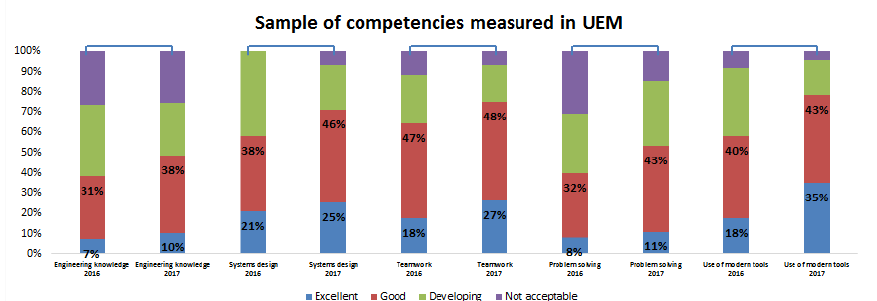
Fig. 3. Comparison of levels of achievement in UEM-related competencies in UTEC’s previ- ous vs. present education models. Faculty members were asked to fill-out detailed ru- brics for each student in every course and in relation to specific competencies. The bar graphs show a significant increase of “good” (in red) and “excellent” (in blue) scores in 2017 vs. 2016, which coincides with the launch of the new educational